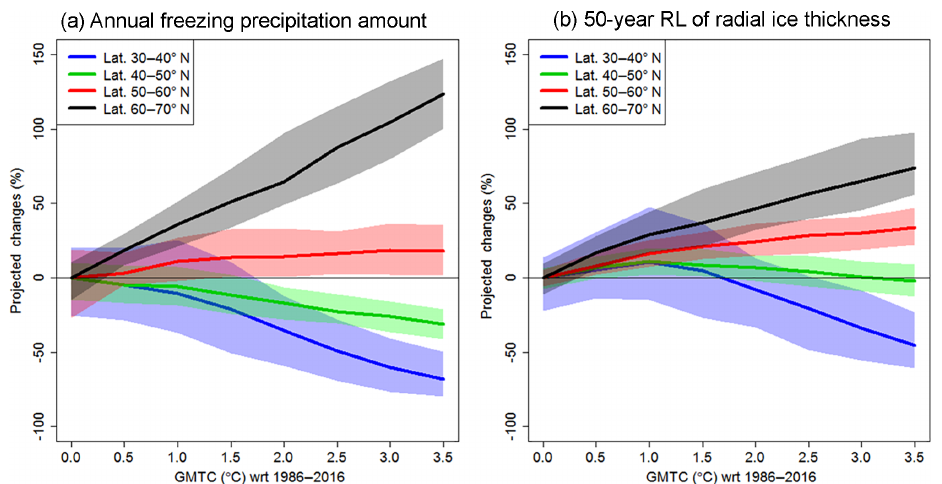
Figure 6. Zonal averages of projected changes in the CanRCM4 large ensemble to annual FP amount (a) and 50-year RL radial ice thick- ness (b) for four different latitude zones (i.e., 30–40, 40–50, 50–60 and 60–70 ◦ N latitudes) over North America, as a function of global mean temperature change (GMTC) relative to the baseline period. Minimum and maximum values of areas and lines represent 5th and 95th percentiles and median values, respectively, obtained from the